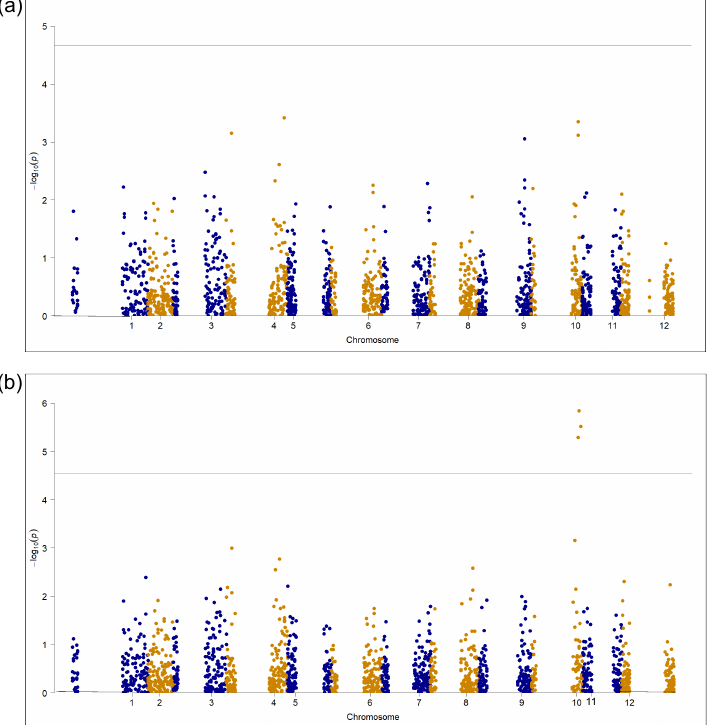
Figure 7. Manhattan plot of GWAS results, additive model, for ‘off-the-field’ fry colour (OTF) in 2017 population with the SNPs ( a ) and the multiallelic haplotypes ( b ). Horizontal line shows the QTL significance threshold at 4.54 (Bonferroni correction, level =